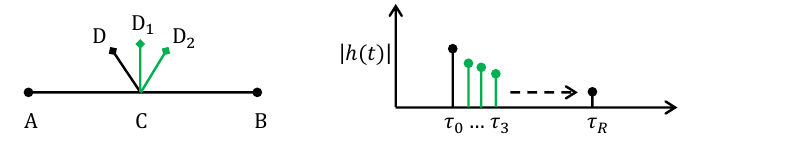
Figure 5. Response of path delay impulses with the increase in branching